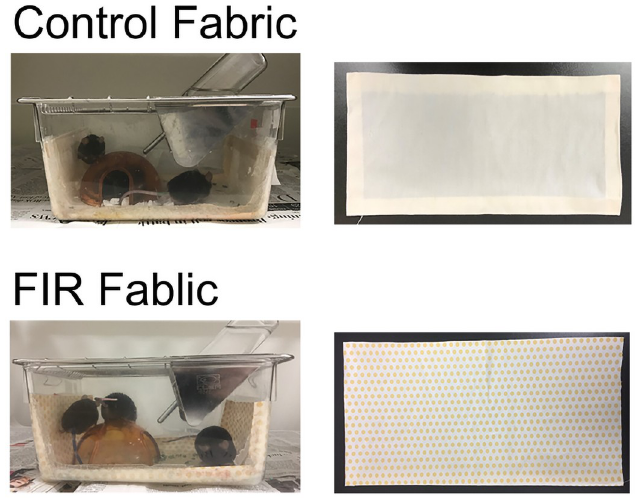
Fig 1. The animal cages with a fabric that generates FIR light or with a control fabric. Sections of fabric derived from the same source cloth were present in both cages, but the fabric in one case was impregnated with a compound that generates far IR